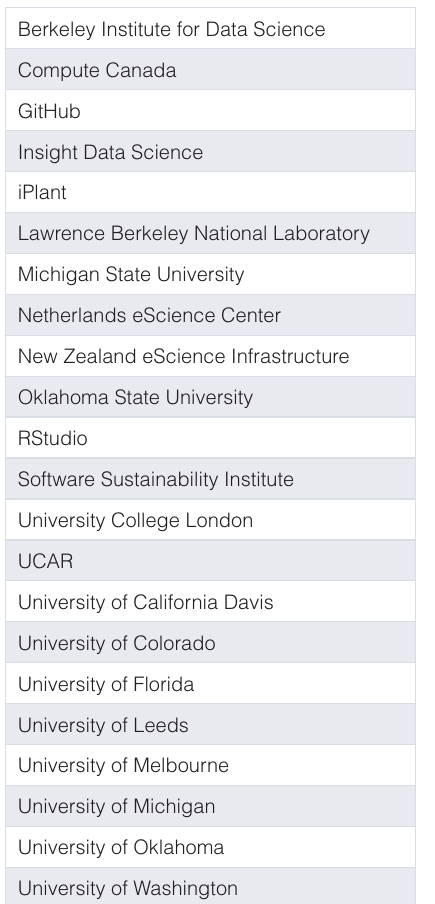
Table 1. Current Partners (November